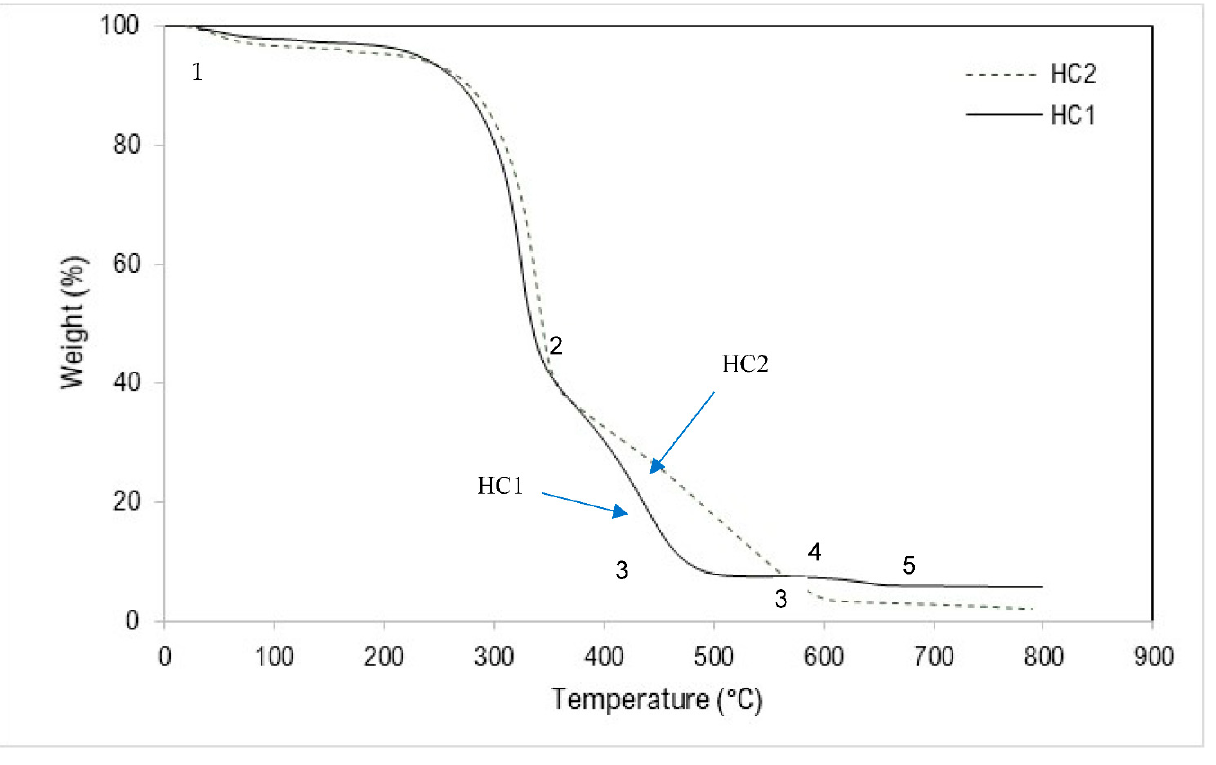
Figure 6. The TG physicochemical properties of HC1 (220 °C) and HC2 (230 °C) (10 °C/min, 50L/min N2